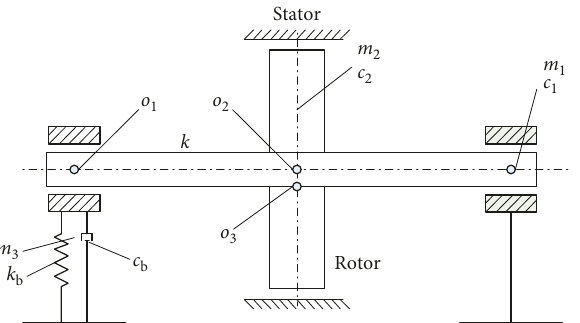
Figure 2: Bearing-rotor system with pedestal looseness coupled with